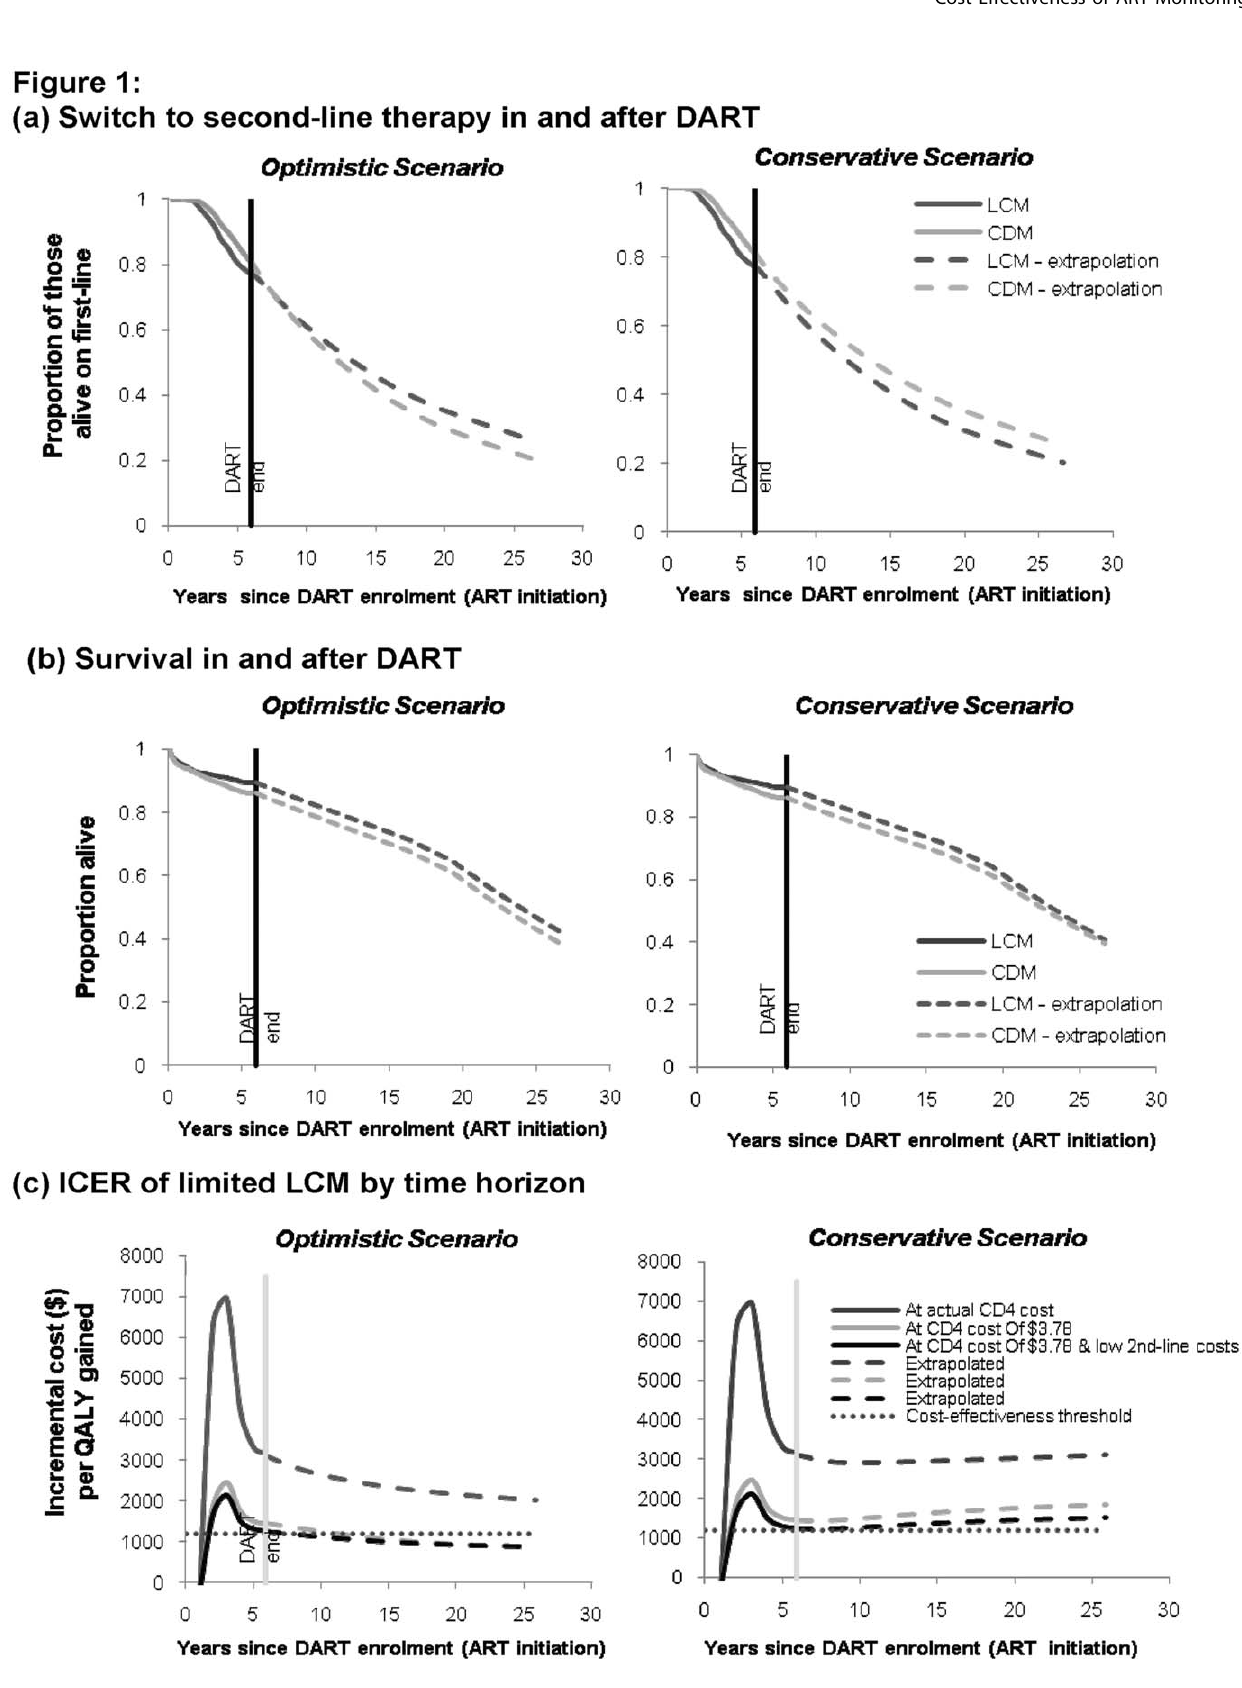
Figure 1. Long-term extrapolation of outcomes and ICERs.